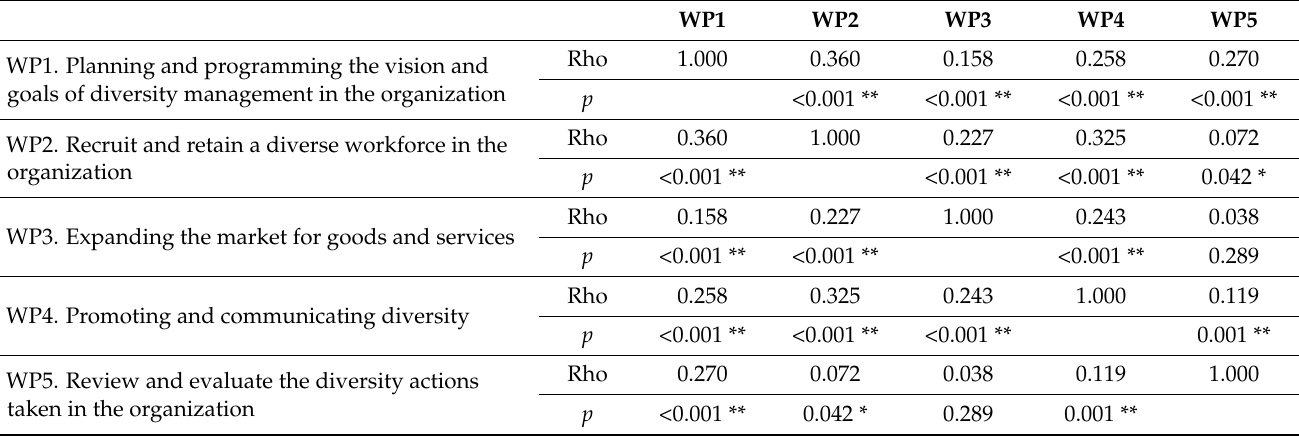
Table 3. Assessment of the correlation between individual dimensions of the 5P